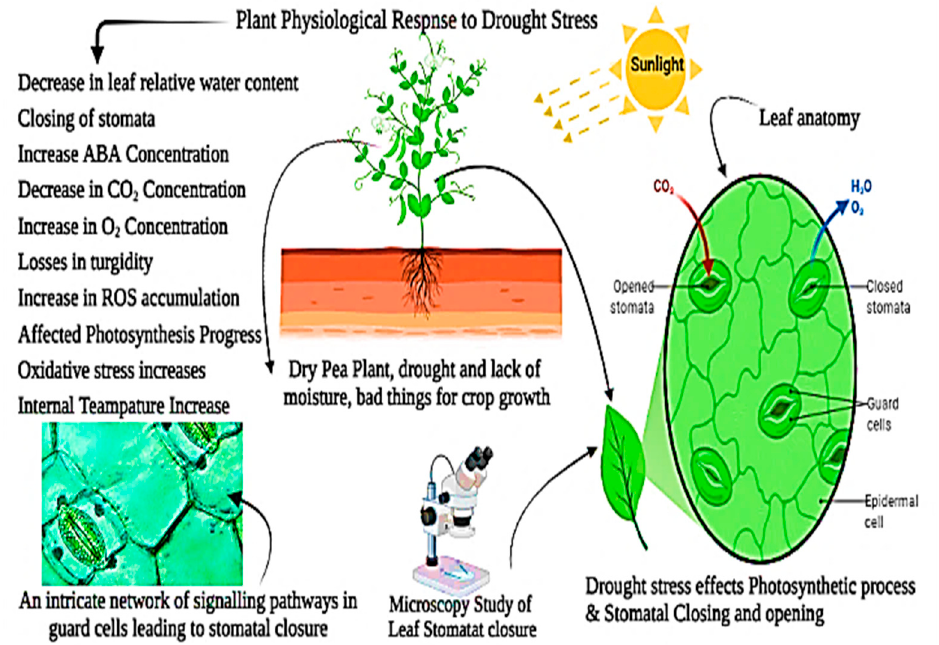
Figure 5. Drought stress and morpho-physiological responses in pea plants; drought stress affects photosynthetic pigments and leaf stomatal openings and closings in pea crops ( Pisum sativum L.).